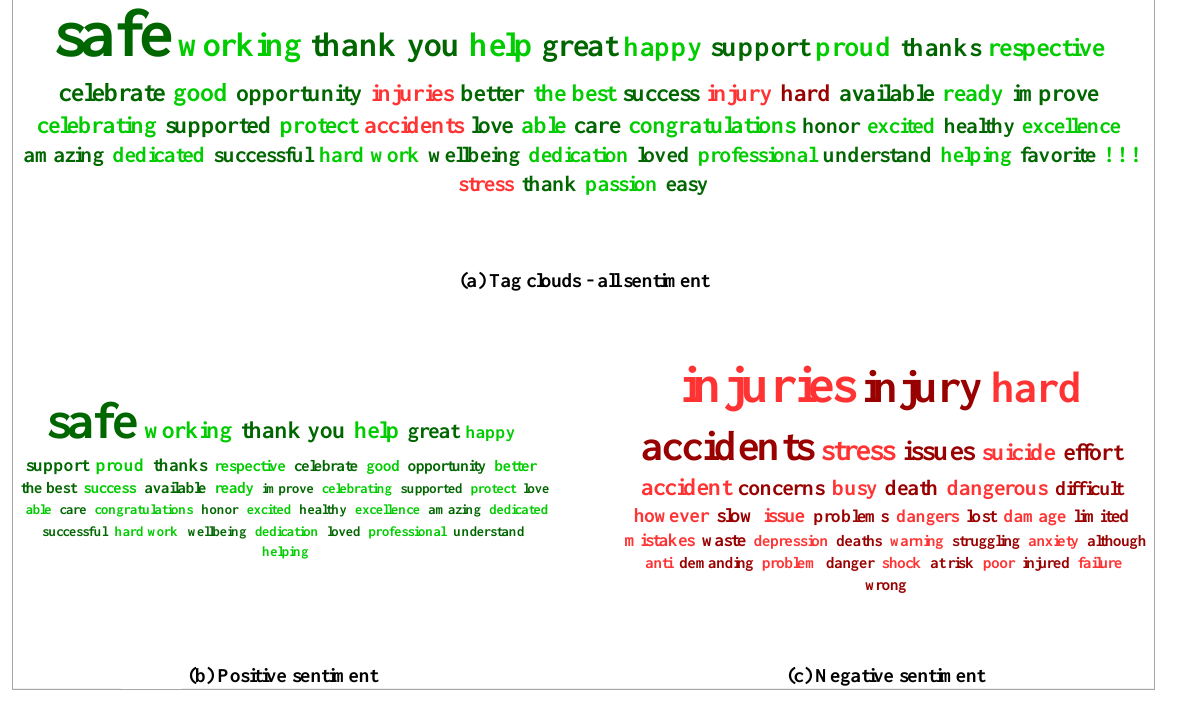
Figure 7. Tag clouds: ( a ) all sentiment, ( b ) positive sentiment, and ( c ) negative sentiment. Table 5. Source data.